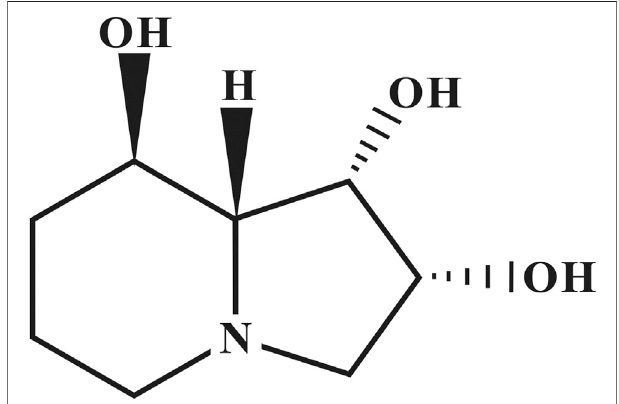
FIGURE 1 | The chemical structure of